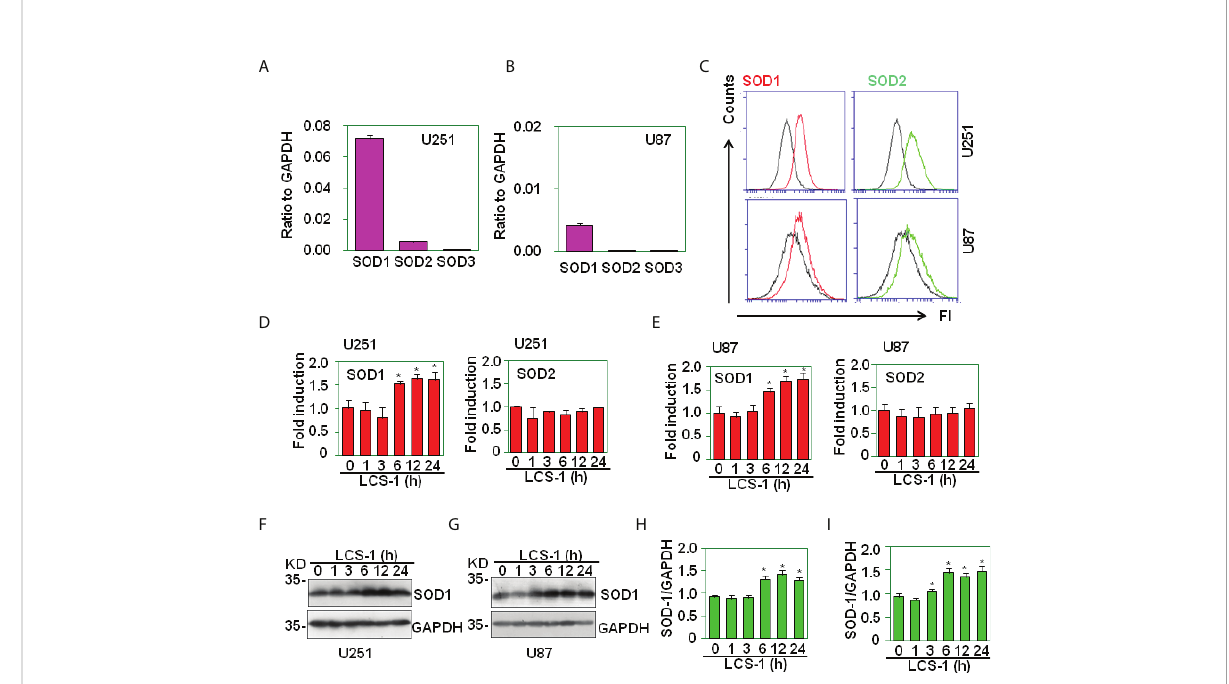
FIGURE 2 The expression of SOD1, SOD2 and SOD3 in glioma cell lines. (A) qRT-PCR analysis of SOD1, SOD2 and SOD3 mRNA levels in U251 cells. (B) qRT-PCR analysis of SOD1, SOD2 and SOD3 mRNA levels in U87 cells. (C) FACS analysis of SOD1 and SOD2 protein levels in U251 and U87 cells. (D) qRT-PCR analysis of SOD1 and 2 mRNA levels in U251 cells treated with 10 µM LCS-1 for the indicated time periods. * P < 0.05 compared with the medium groups. (E) qRT-PCR analysis of SOD1, SOD2 and SOD3 mRNA levels in U87 cells treated with 10 µM LCS-1 for the indicated time periods. * P < 0.05 compared with the medium groups. (F, G) Western blot analysis of the protein levels of SOD1 in U251 (F) and U87 (G) cells. (H, I) The quantitative data from F (H) and G (I) respectively. * P < 0.05 compared with the medium